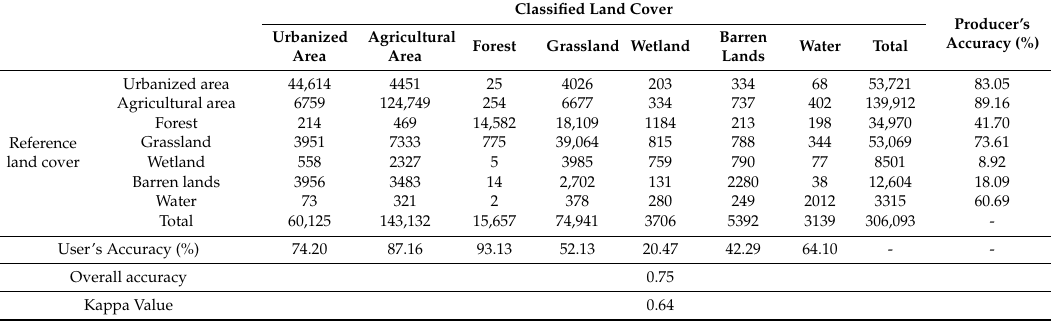
Table 3. Accuracy metrics and verification indices of the Daeso-myeon area (unit: 1000 pixels).